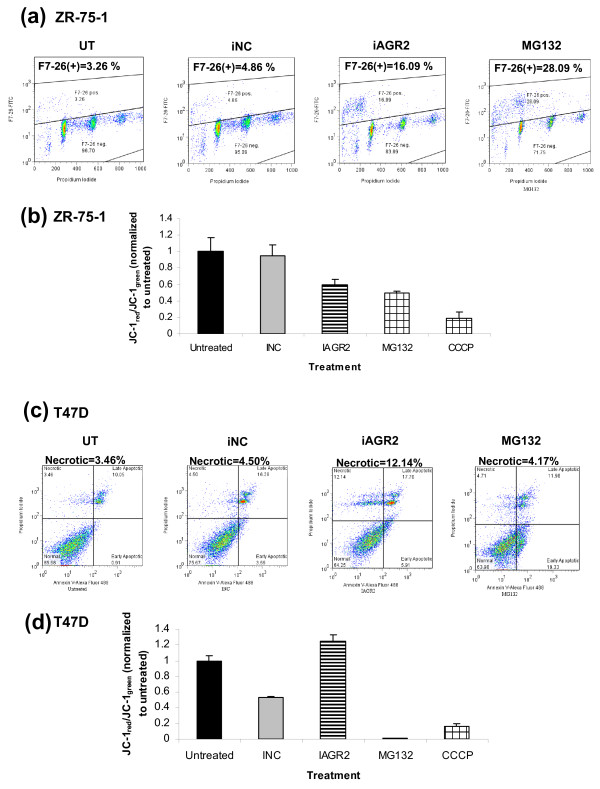
AGR2 knockdown induces cell death. ZR-75-1 cells were collected 96 hours after AGR2 knockdown and analyzed for cell death by measuring ssDNA breaks by using the following: (a) F7-26 staining by FACS analysis, and (b) alterations in mitochondrial membrane potential by determining the ratio of JC-1red to JC-1green and represented as a ratio of the untransfected control (±SD), n = 3. MG132 and CCCP served as apoptosis and depolarization controls, respectively. Cell death was investigated 96 hours after AGR2 knockdown in T47 D cells by using the following: (c) annexin V (AV) and propidium iodide (PI) and gated on normal (AV-/PI-), necrotic (AV-/PI+), early apoptotic (AV+/PI-), and late apoptotic/necrotic (AV+/PI+) cells; and (d) JC-1 staining, as previously described.